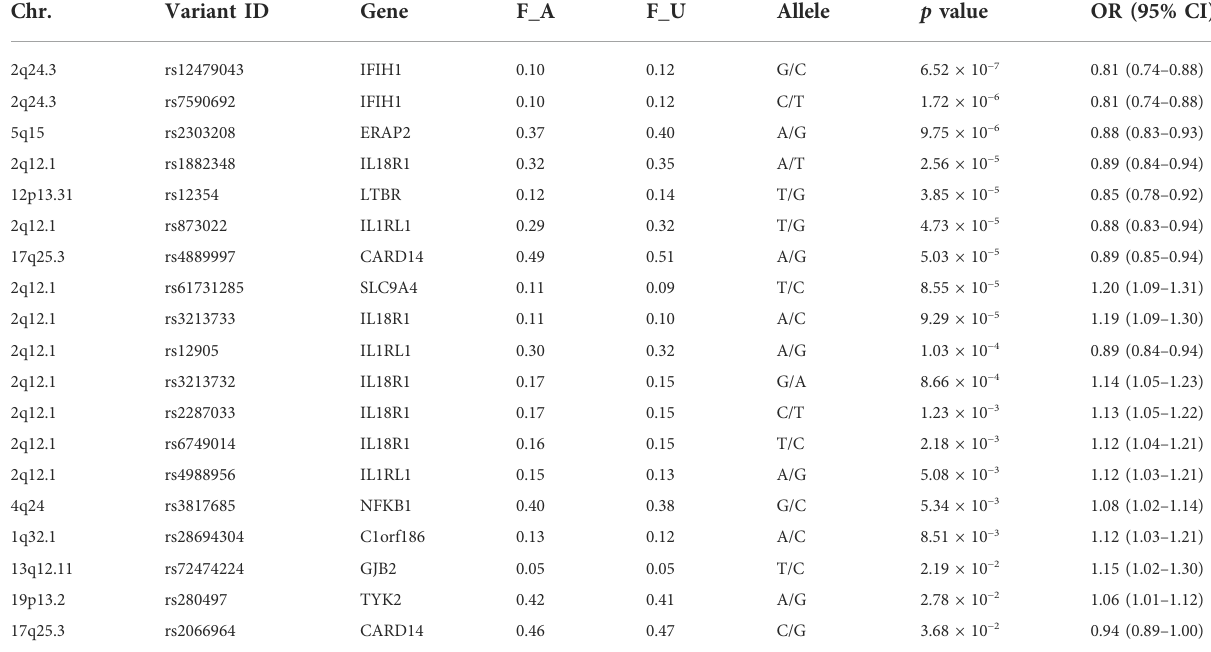
TABLE 1 SNPs with signi fi cance in replication analysis. Chr.